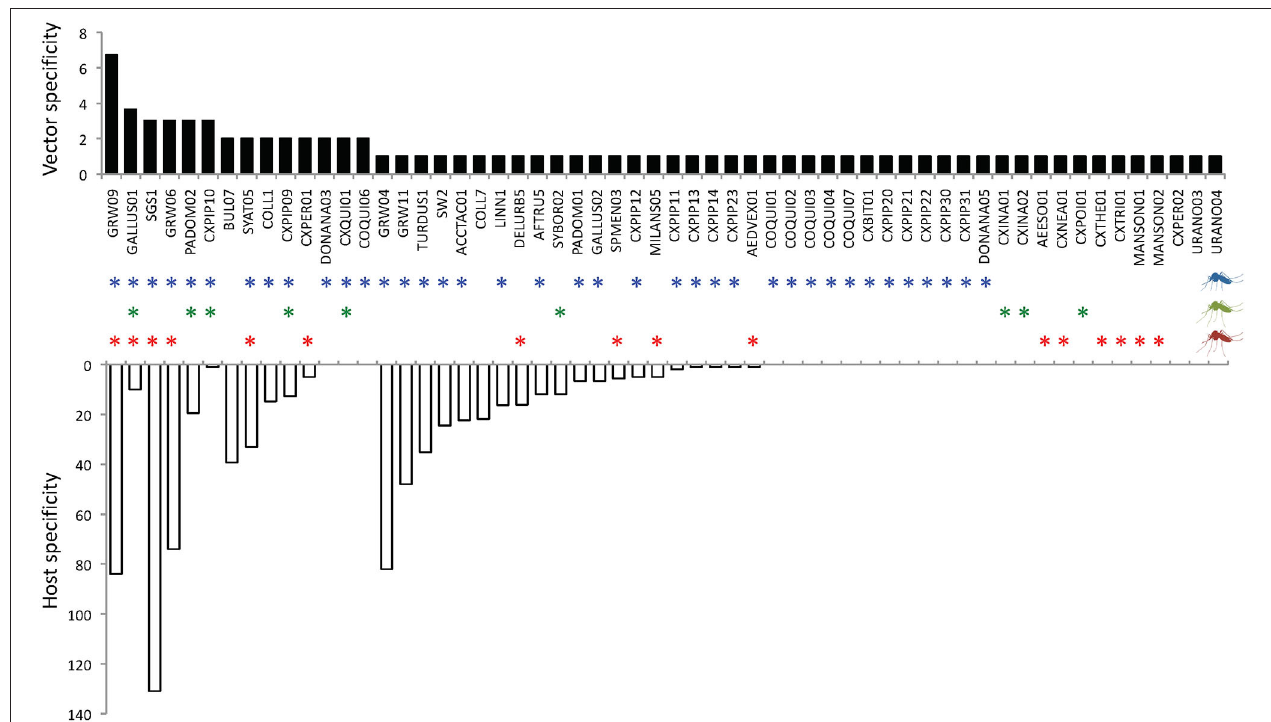
FIGURE 3 | Vector specificity of parasites of the 58 Plasmodium lineages found in head and thorax of vectors and the associated host specificity of lineages that were found in birds ( N = 31). Blue, green, and red asterisks correspond to lineages that were found in ornithophilic, opportunistic and mammophilic mosquitoes,